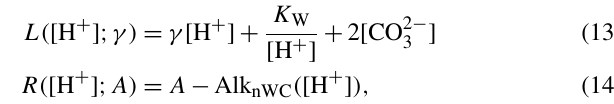
Figure 2. Schematic representation of the general characteristics of the L( [ H + ]; γ) and R( [ H + ]; A) components of the alkalinity– pH equation for the Alk T − CO 2 − pair. The grey band delimits 3 the (monotonous) variations of R( [ H + ]; A) for a given alkalin- ity A . The band moves up and down without being distorted as A is increased, respectively, decreased. For a given pair of Alk T – CO 2 − concentrations, the actual equation to solve is L( [ H + ]; γ) = 3 [ CO 2 − ] 3 R( [ H + ]; Alk T ) , where γ = K